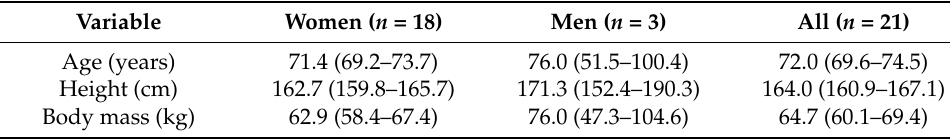
Table 1. Anthropometric characteristics of study volunteers.